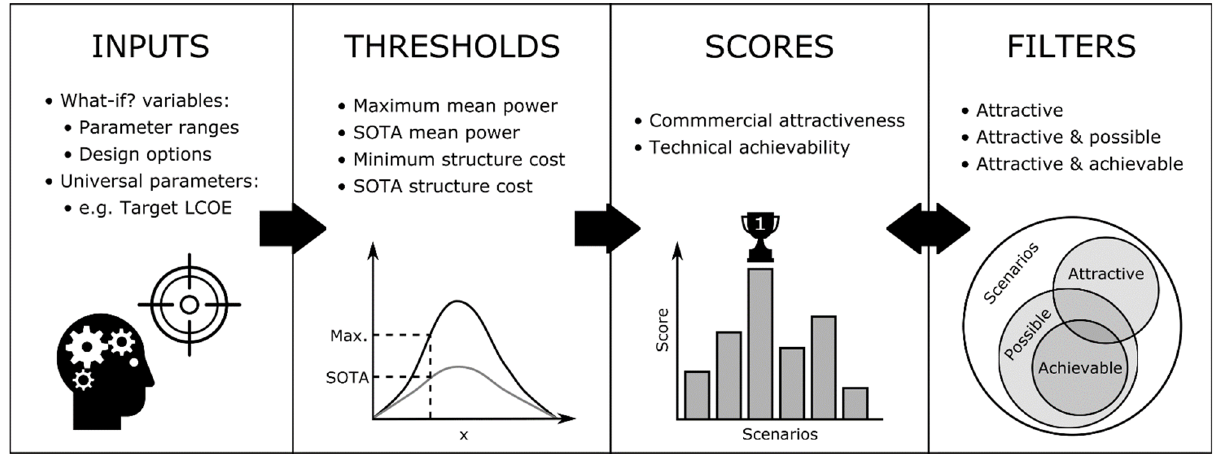
Figure 1. The structure of Section 3: ‘Methodology for Creating and Ranking Scenarios of WEC Parameters’ and also the workflow of the scenario creation tool in terms of the key user inputs, calculated thresholds, output scores and scenario filters.